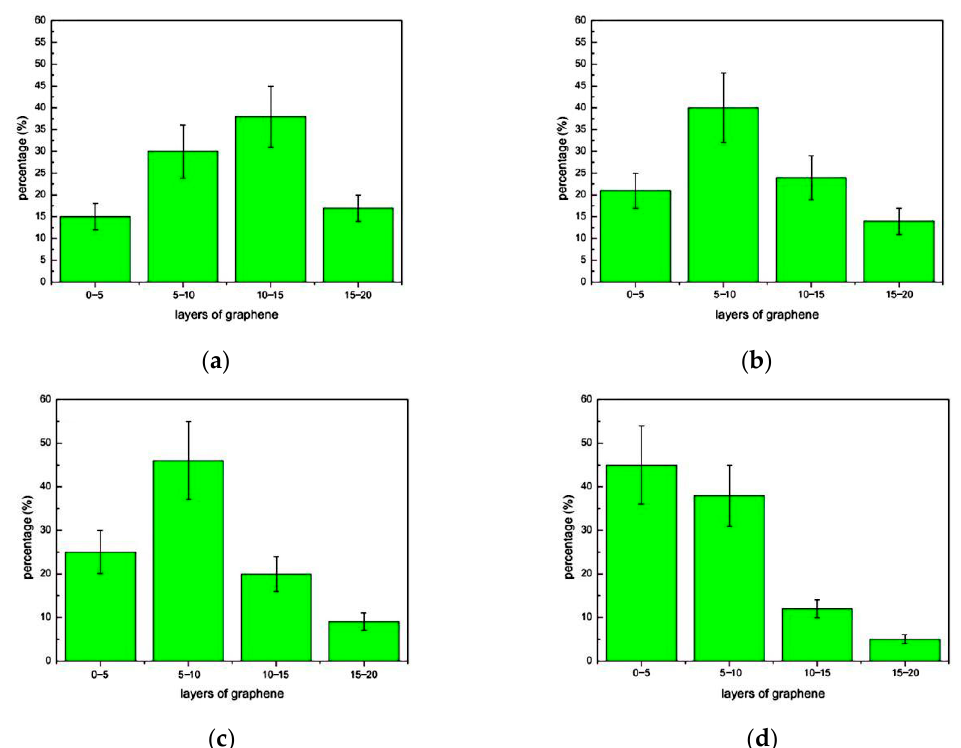
Figure 8. Histogram of graphene layers distribution in composite under different rotational speeds. ( a ) 160 rpm; ( b ) 200 rpm; ( c ) 240 rpm; ( d ) 280 rpm.